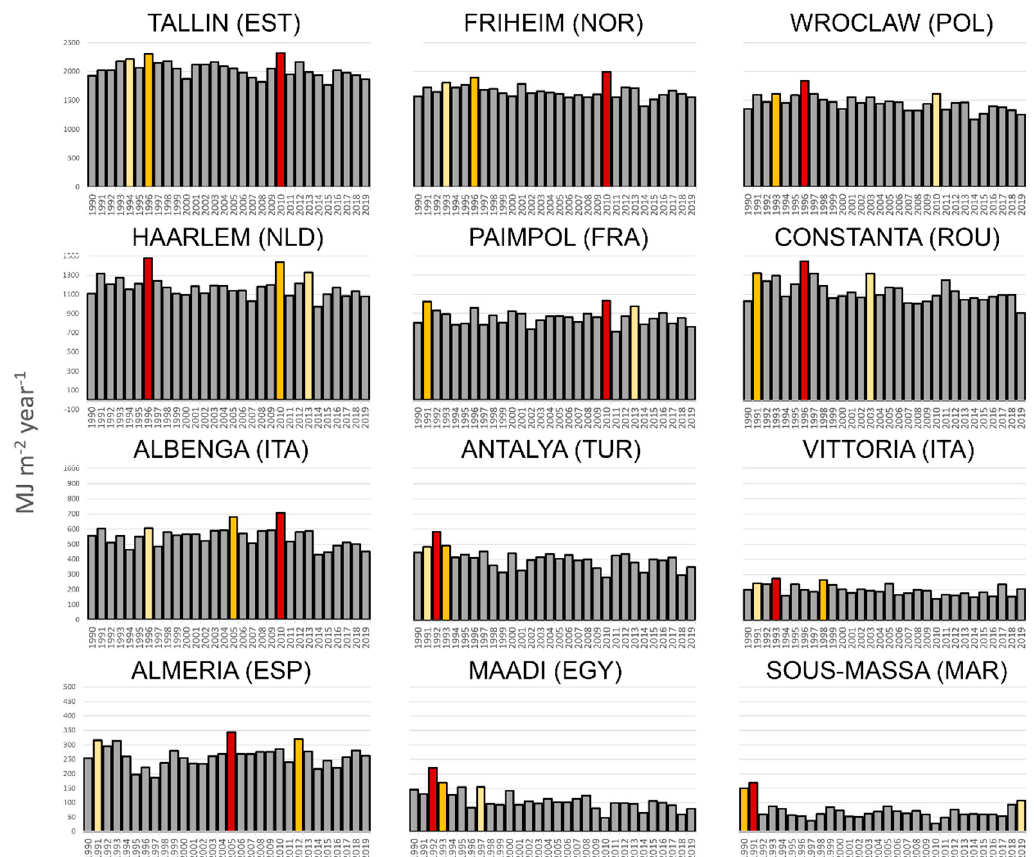
Figure 2. The cumulative energy requirements for growing rose plants for cut rose flowers in protected cultivation with the temperature set at the optimal range for this floriculture crop in di ff erent European countries. The years with the three highest levels of consumption are colored red, orange, and yellow for the 1 st , 2 nd and 3 rd position respectively from 1990 to 2019. In order to make the interannual variability clear for each site, the range of y axis changes for each line of the figure, according to the average level of energy requirement of the site.